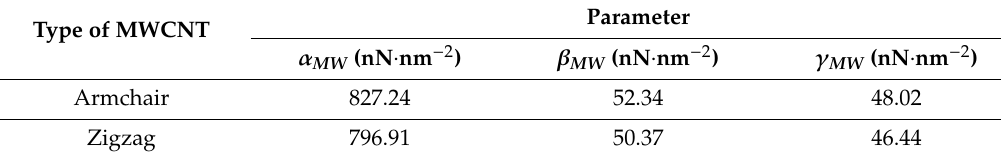
The fitting parameters for armchair and zigzag MWCNTs are given in Table 4. The mean di ff erence between the values of the EA MW , EI MW , and GJ SW rigidities calculated with Equations (19)–(21) and the values obtained directly from FE analysis are, respectively, 0.10%, 1.23%, and 0.45% for armchair nanotubes and 0.35%, 0.97%, and 0.31% for zigzag nanotubes. Table 4. Fitting parameters α MW , β MW , and γ MW for the armchair and zigzag MWCNTs. Type of MWCNT